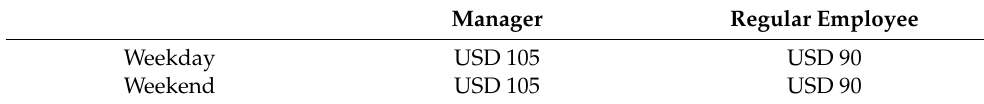
Table 5. Costs for all regular employees during nighttime (unit: